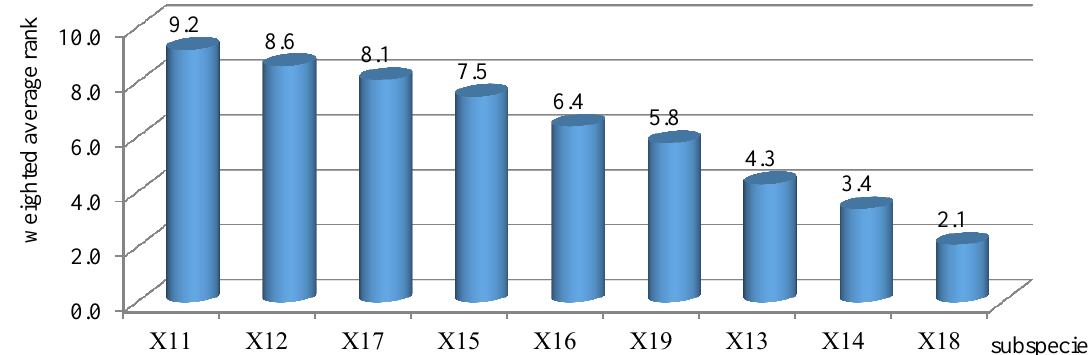
Fig. 2. Distribution risk histogram in the field of FEA, inherent pharmaceutical enterprises